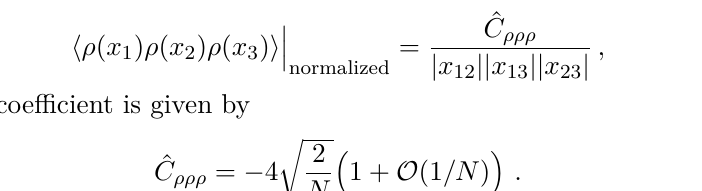
(1 /N ) correction to the three-point function O